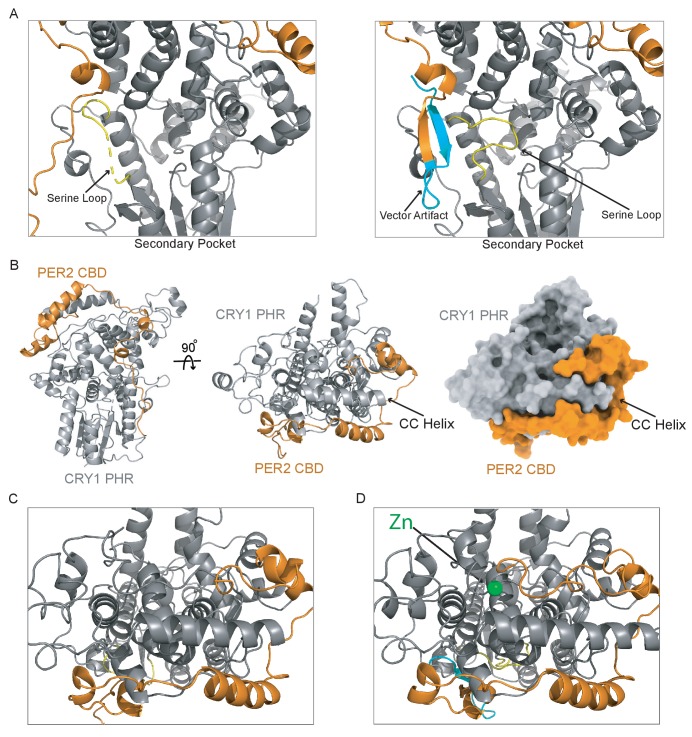
Additional views of the new CRY1 PHR:PER2 CBD crystal structure.(A) Left, zoomed in view of the secondary pocket (CLOCK PAS-B binding site) of our crystal structure (PDB: 6OF7) showing the partially ordered serine loop (yellow). Right, same view of the secondary pocket from the previously published CRY1 PHR:PER2 CBD crystal structure (PDB: 4CT0) (Schmalen et al., 2014) with the serine loop (yellow) that is ordered by contact with the vector artifact (cyan). (B) Crystal structure of CRY1 PHR:PER2 CBD. CRY1 PHR is shown in gray and PER2 CBD is shown in orange. The standard view is shown in ribbon representation (left) and a 90° rotation along the horizontal axis to display the CC helix, where the TAD of BMAL1 binds, is shown in ribbon (middle) and surface (right). (C) Zoomed in view of the CC helix. (D) Zoomed in view of the CC helix of the previously solved crystal structure of CRY1 PHR:PER2 CBD (4TC0). CRY1 PHR is shown in gray and PER2 CBD is shown in orange. The far C-terminus of the CBD of PER is coordinating a zinc ion (green) with CRY1 PHR. The zinc ion and subsequent coordinating residues are missing from the new structure. See Supplementary file 2 for more information.